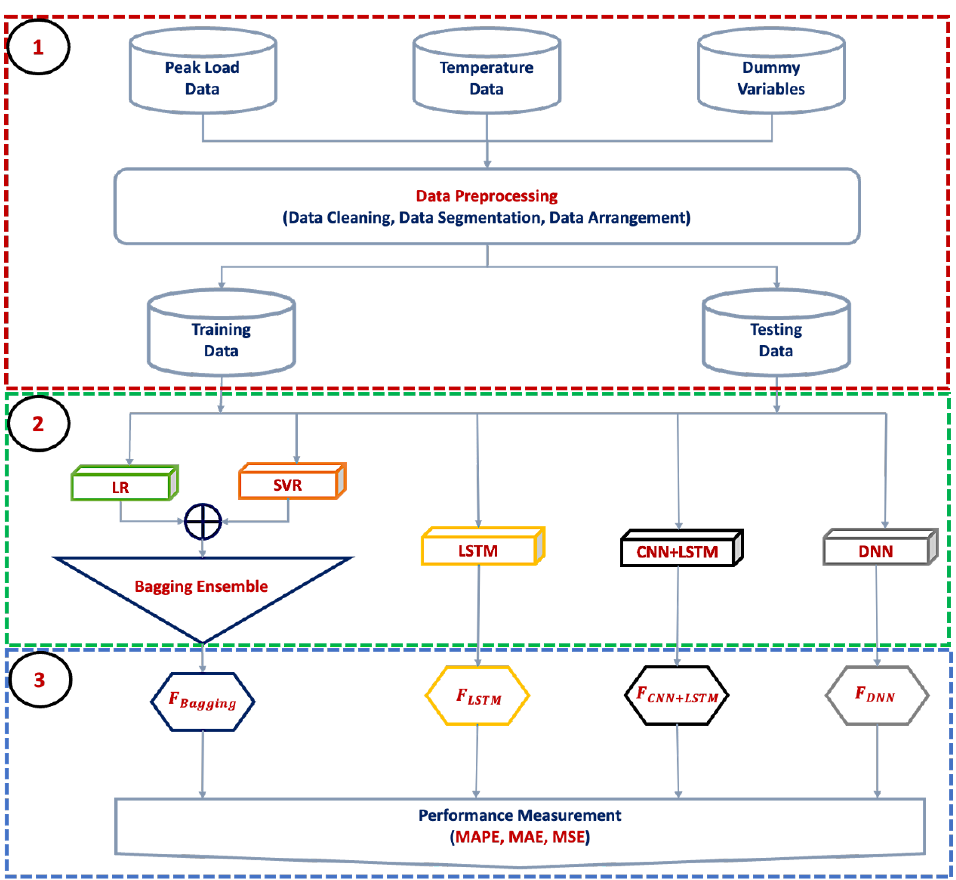
Figure 1. Overview of the integrated system for STLF, including 1. data pre-processing module, 2. training module, and 3. forecasting